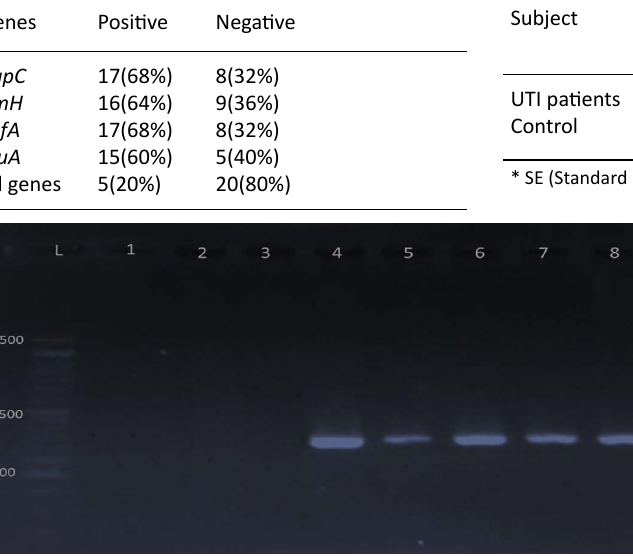
Table 3. IL-17A urine level in Patients with UTI